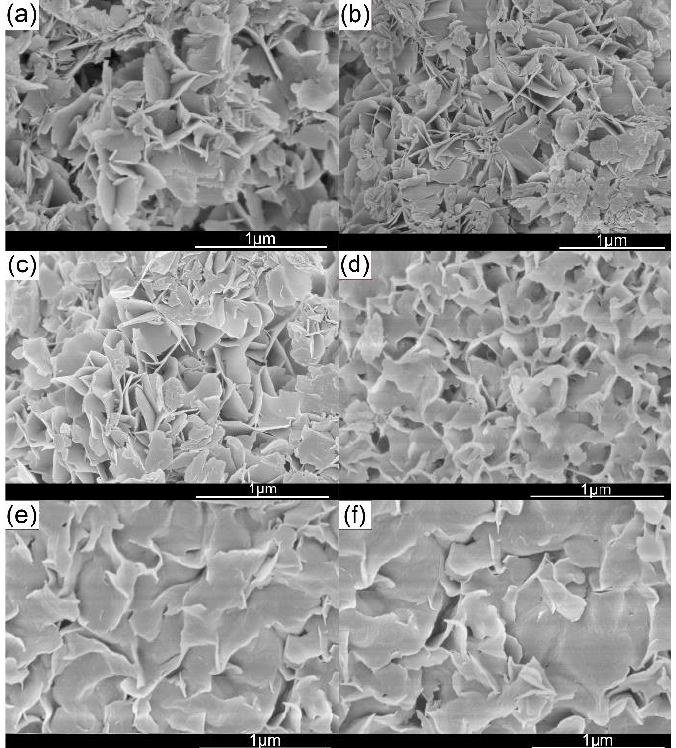
Figure 7. SEM images of as-prepared Mg(OH) 2 . ( a ) Additive free; ( b ) 0.2 g/L; ( c ) 0.4 g/L; ( d ) 0.6 g/L; ( e ) 0.8 g/L; ( f ) 1.0 g/L.